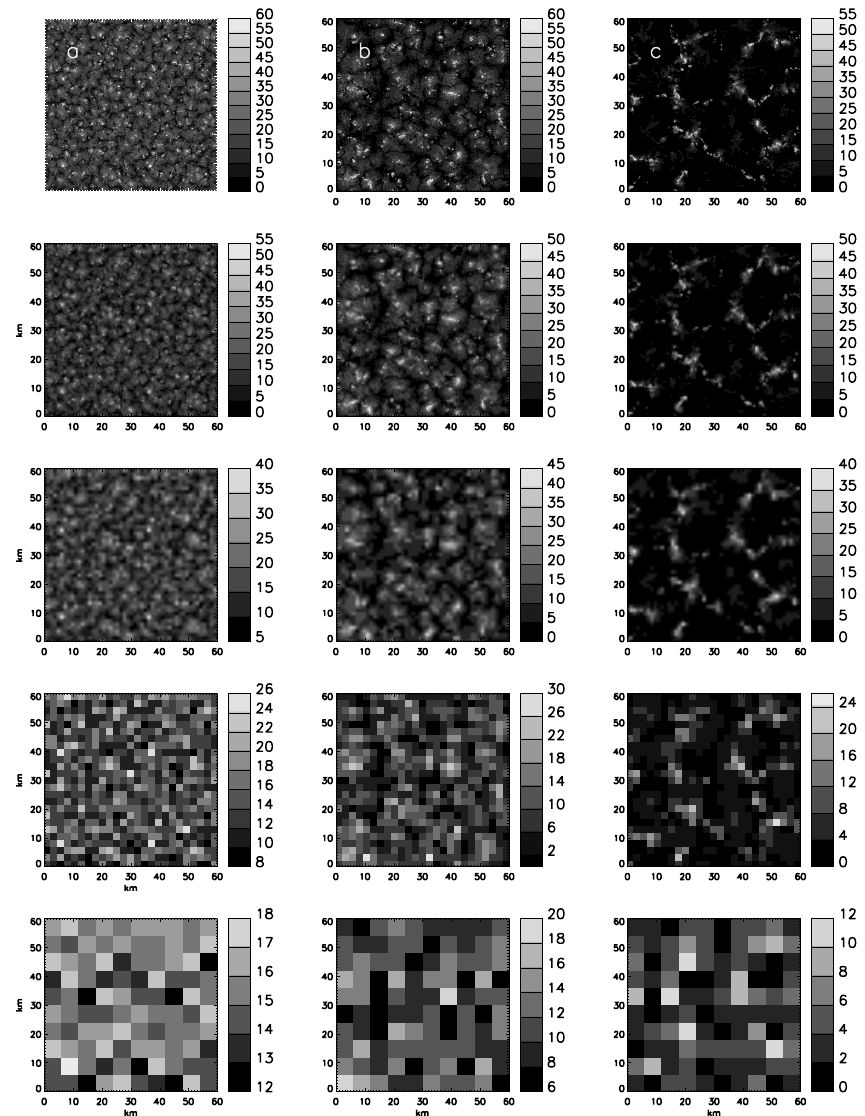
Fig. 4. Modeled τ c for three aerosol conditions and stages of temporal evolution: (a) N a = 500cm − 3 , t = 3 h, (b) N a = 500cm − 3 , t = 6 h, (c) N a = 150cm − 3 , t = 9 h. The five levels of aggregation (rows) represent resolutions of 0.3, 0.6, 1.2, 2.4, and